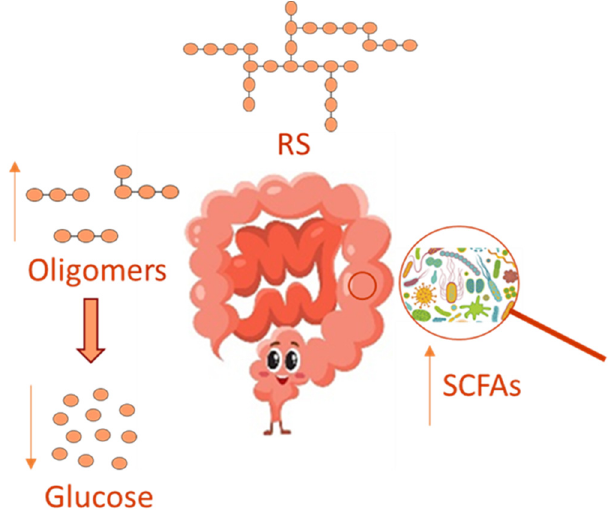
Figure 2. Resistant starch effect on the GI and microbiome SCFAs